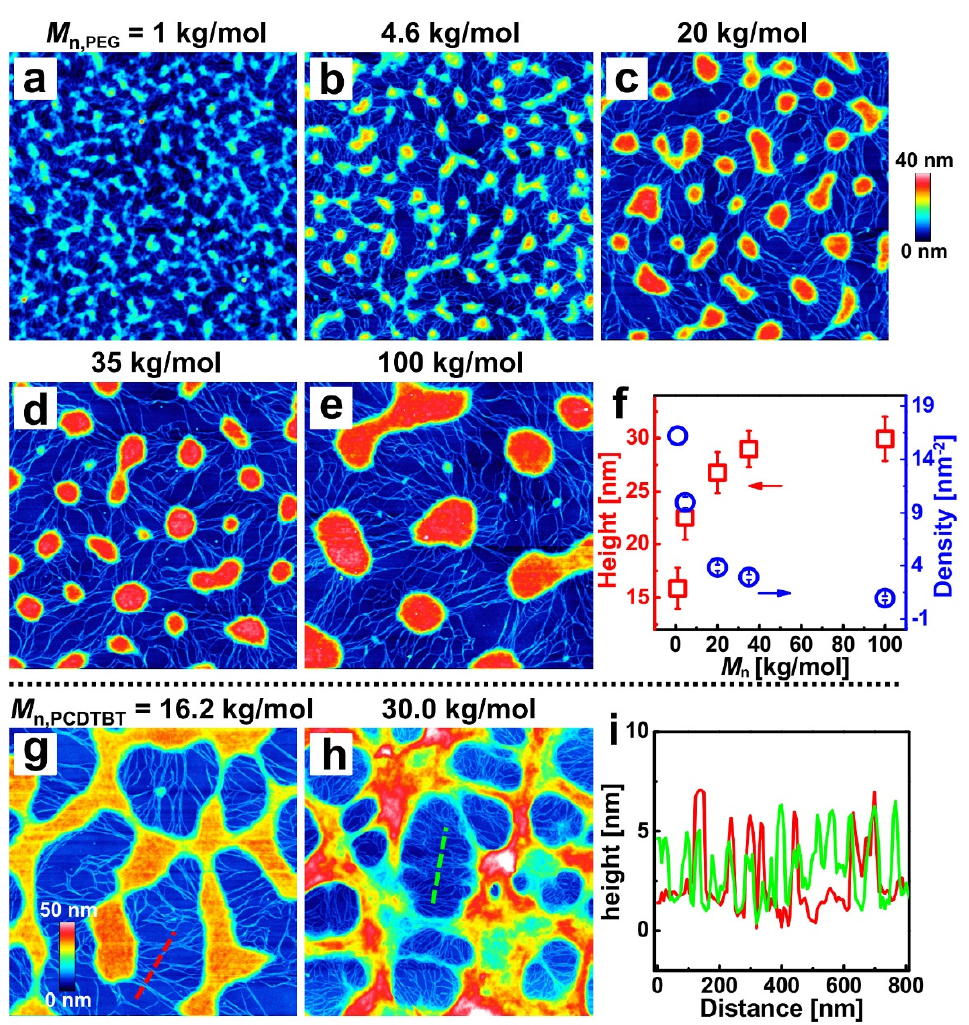
Figure 3. Effects of the molecular weight of PEG and PCDTBT on the morphology of blend films. AFM height images of the washed films correspond to blend films produced with different molecular weights of PEG: ( a ) 1, ( b ) 4.6, ( c ) 20, ( d ) 35, and ( e ) 100 kg/mol. ( f ) The plot of the height and density of PCDTBT aggregates against the M n of PEG. AFM height images of the washed films correspond to blend films prepared with PCDTBT molecular weights of ( g ) 16.2 and ( h ) 30.0 kg/mol. ( i ) Cross-sectional profiles along the dash lines in ( g , h ). The size of each AFM image is 3 × 3 μ m 2 .